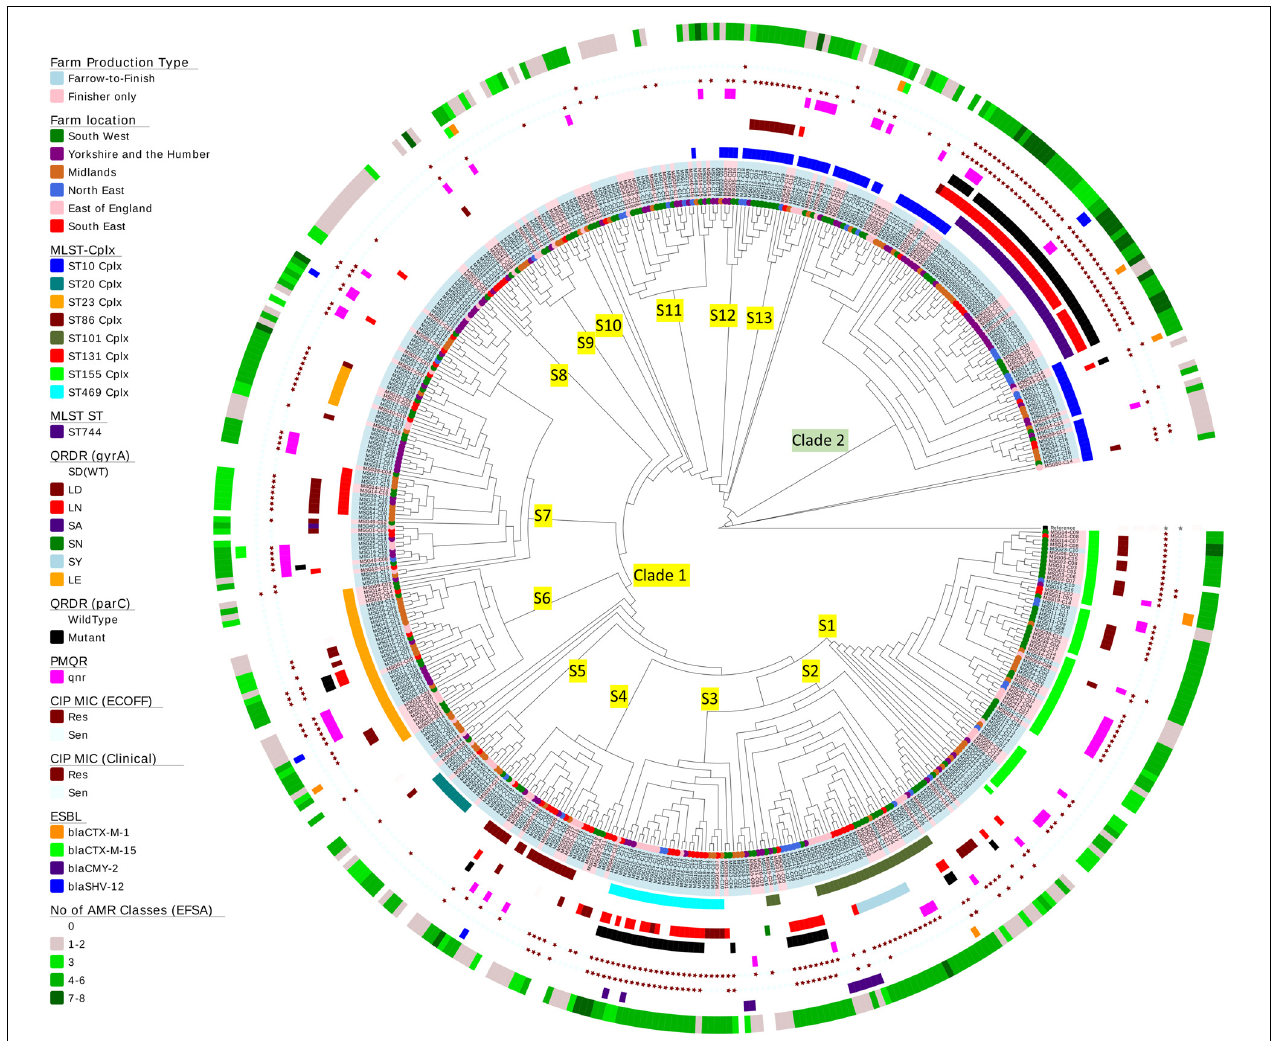
FIGURE 3 | Phylogenetic tree of Escherichia coli isolates. A SNP-based maximum-likelihood phylogenetic tree was constructed in RaxML-NG using 272,385 single nucleotide polymorphisms (SNP) present in the core genome. Clades and subclades are labeled on the relevant branches. Isolate names are colored according to farm production type (blue, farrow-to-finish; pink, finisher-only) and nodes at the end of the leaves are colored according to the six regions in England from where the E. coli isolates originate. The circles at the edge indicate the following information (working from inner circle to outer circle): (1) the top 8 MLST clonal complexes identified; (2) MLST ST744; (3) QRDR mutations in gyrA ; (4) QRDR mutations in parC ; (5) presence of plasmid quinolone resistance ( qnr genes); (6) ciprofloxacin susceptibility using EUCAST ECOFF; (7) ciprofloxacin susceptibility using EUCAST clinical breakpoints; (8) presence of ESBL gene variants; and (9) the numbers EFSA AMR classes harboring different resistance genes in each isolate (genes conferring resistant to the same antimicrobial were grouped within the same